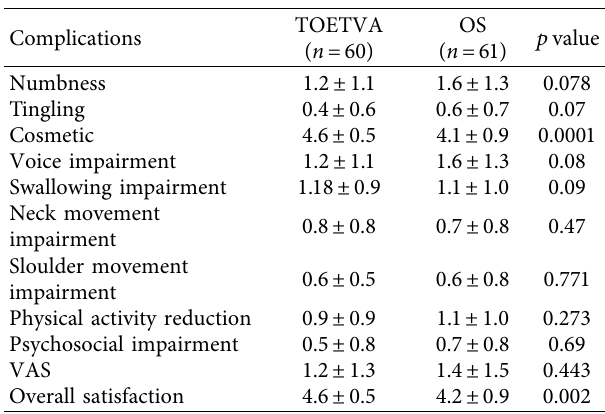
Table 4: Comparison symptoms-related thyroid surgery between the TOETVA group and open surgery group at 4 weeks after surgery.